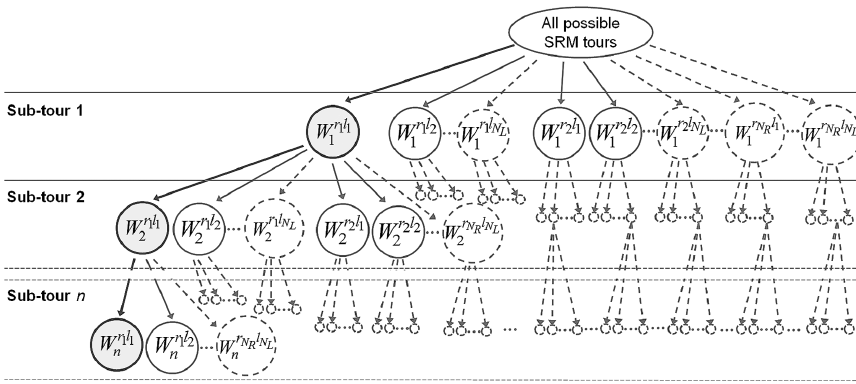
Fig. 5. Optimal routing algorithm solution tree